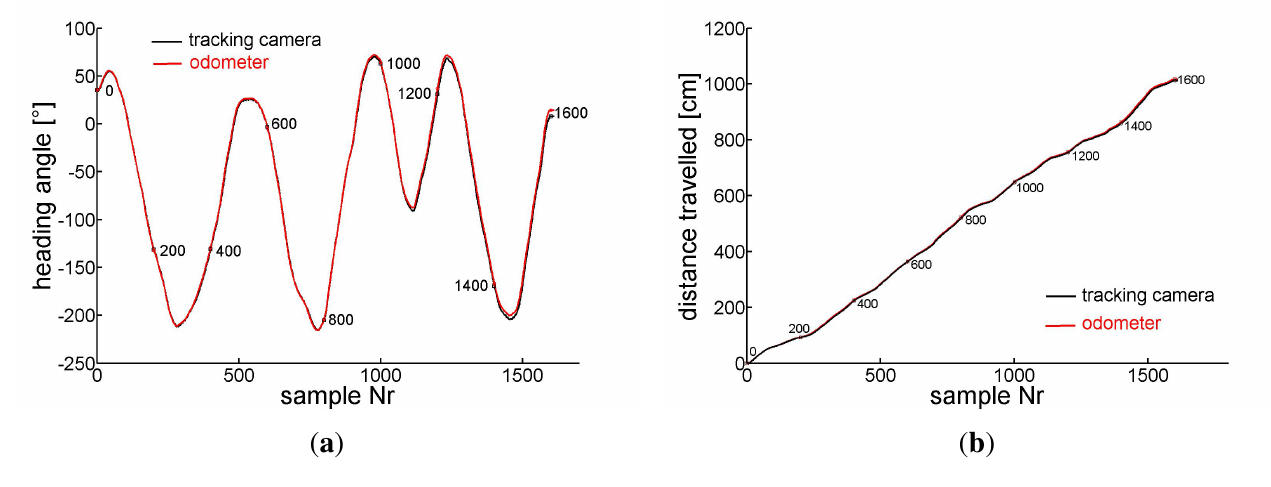
Figure 10. ( a ) The accumulated ρ obtained from the odometer (red) (Equation (7)) and the angular orientation of the carriage extracted from the camera recordings (black) (Equation (11)) during the track shown in Figure 9 are plotted versus the sample number. ( b ) The accumulated τ (red) (Equation (6)) and the distance travelled on the curved track are plotted versus the sample